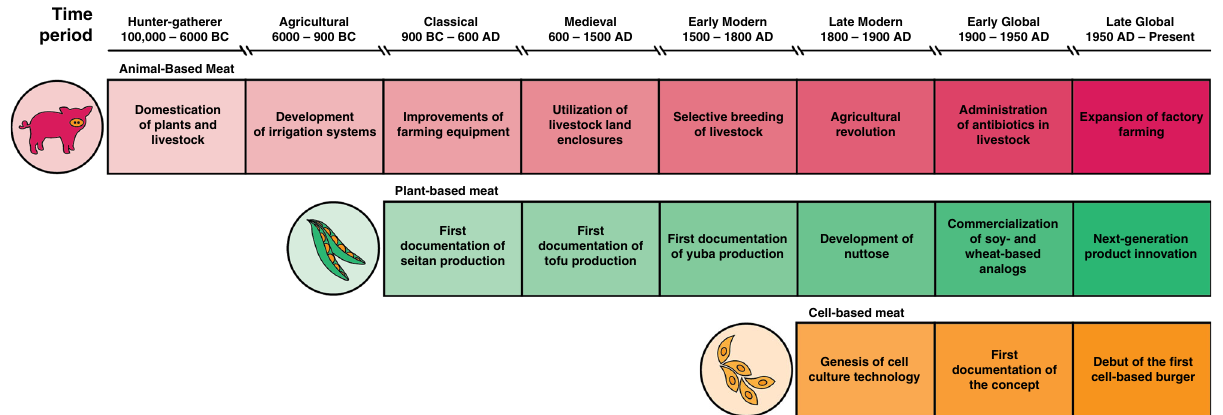
Fig. 1. The history and evolution of animal-, plant- and cell-based approaches to meat production. 13,87 – 93 . Humans have consumed plant-based meat (2555 years ago) for only 0.098% of the time period for which their ancestors have consumed animal-based meat (2,600,000 years ago). Likewise, humans have eaten cell-based meat (7 years ago) for only 0.274% of the time period for which they have consumed plant-based